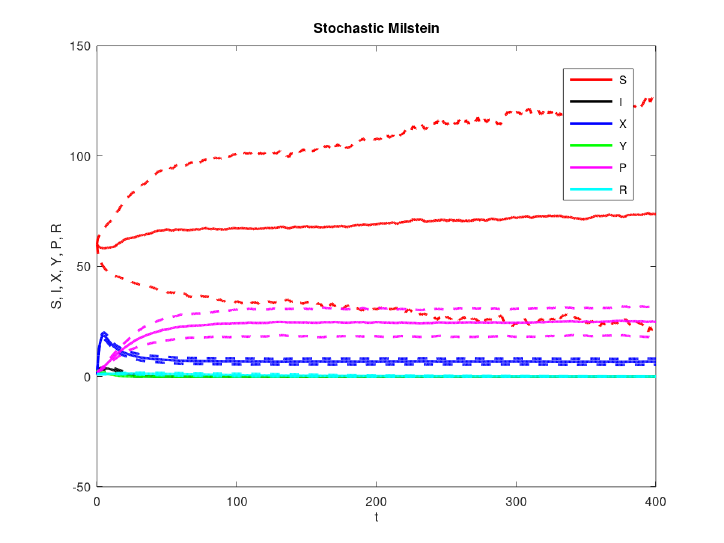
Figure 5. Plots for the plant-virus model for mass action interactions and no delays using the stochastic differential model. The solid lines are the mean values, and the dashed lines are the mean values +/ − one standard deviation. The σ s are equal to